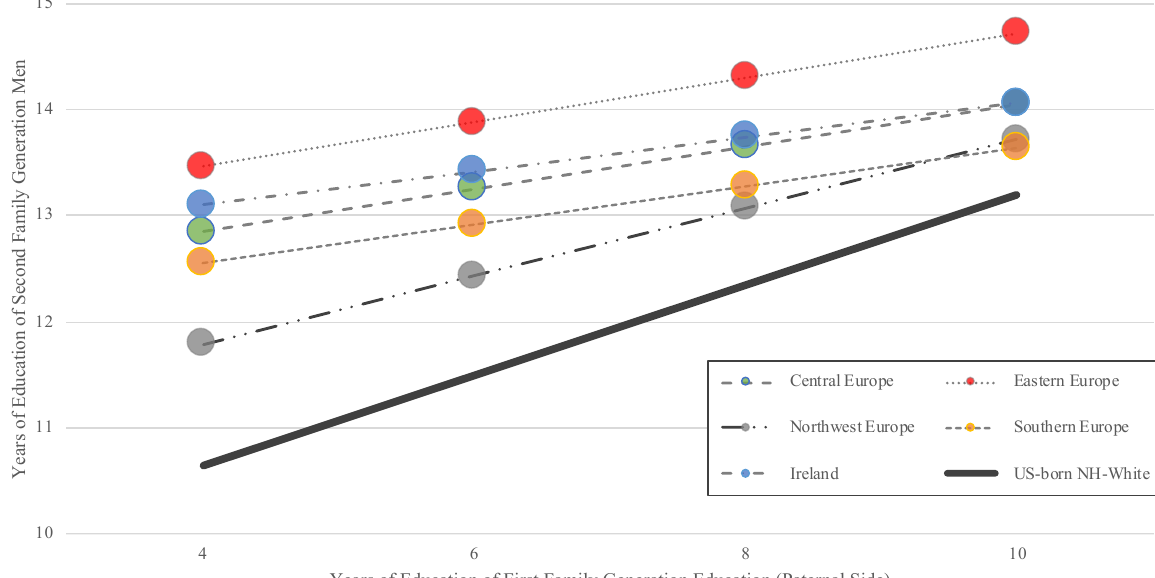
Figure 4: Predicted years of education by maternal education. US-born NH-White indicates U.S.-born non- Hispanic white. Approved for disclosure on November 2, 2020; review number: CBDRB-FY21-039.